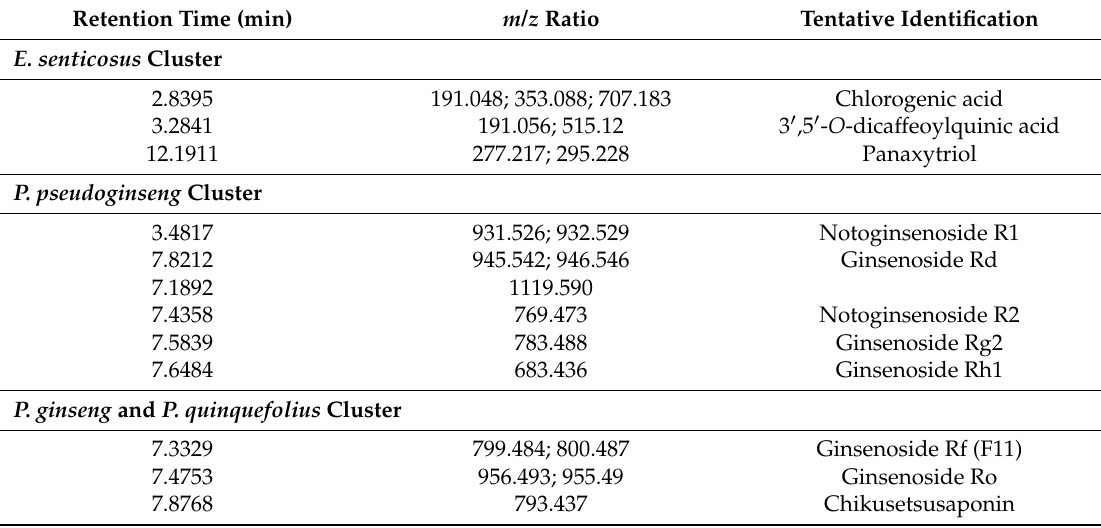
Table 4. Putative biomarkers (retention time/mass pairs) and tentative identification of compounds responsible for the chemical differences between the observed clusters based on UHPLC-MS data.